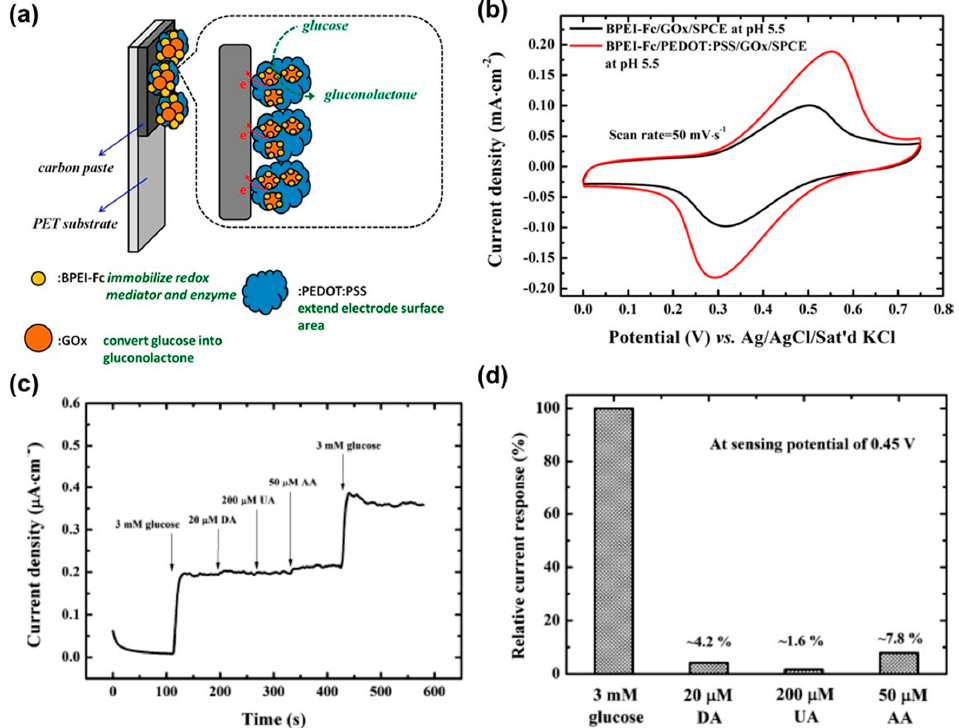
Figure 7. ( a ) Schematic diagram of the BPEI-Fc/PEDOT:PSS/GOx/SPCE; ( b ) CVs of the BPEI-Fc/GOx/SPCE and BPEI-Fc/PEDOT:PSS/GOx/SPCE in PBS solution, pH 5.5 at a scan rate of 0.02 V/s; ( c ) Amperometric i-t response of the BPEI-Fc/PEDOT:PSS/GOx/SPCE to the injection of 3 mM glucose and three common interfering species: 0.02 mM DA, 0.20 mM UA, and 0.05 mM AA. The working potential was 0.45 V; ( d ) Current response of glucose (set as 100%), DA, UA, and AA of the BPEI-Fc/PEDOT:PSS/GOx/SPCE. Reprinted with permission from [65]. Copyright 2013, American Chemical Society. BPEI-Fc: polyethylenimine binding with ferrocene; SPCE: screen-printed carbon electrode; GOx: glucose oxidase.